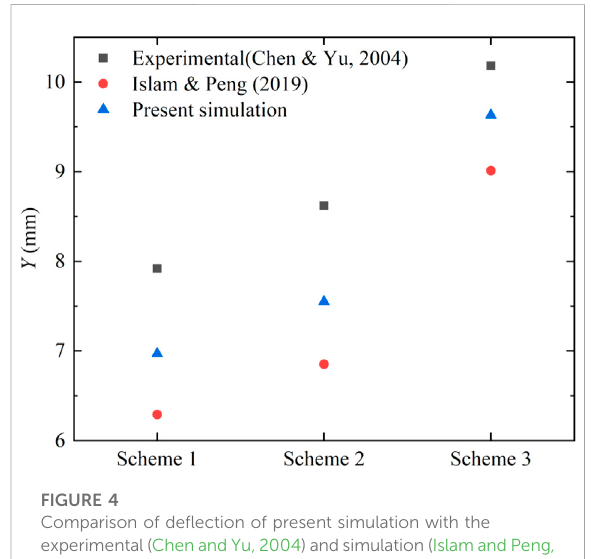
Comparison of de fl ection of present simulation with the experimental(Chenand Yu, 2004)andsimulation (Islamand Peng, 2019) results.